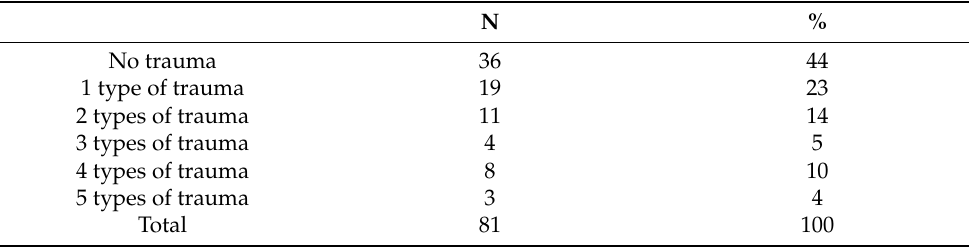
Table 2. Frequency of reported trauma in the mothers’